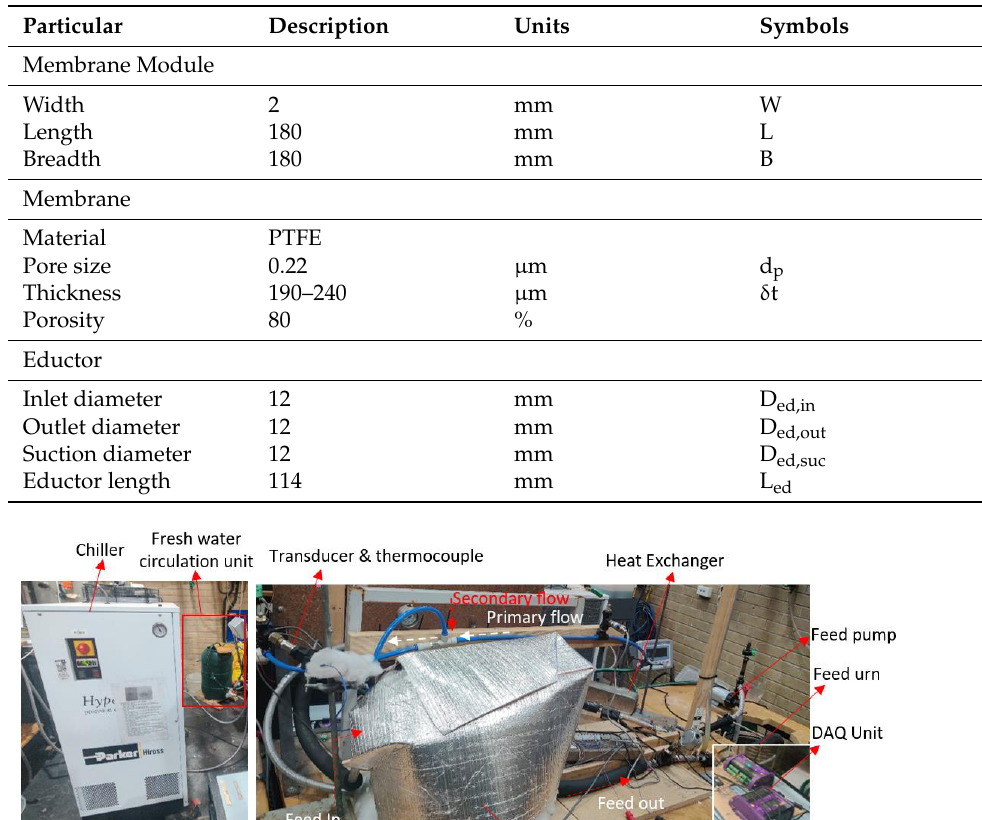
Table 3. Physical properties of membrane module, membrane, and eductor.